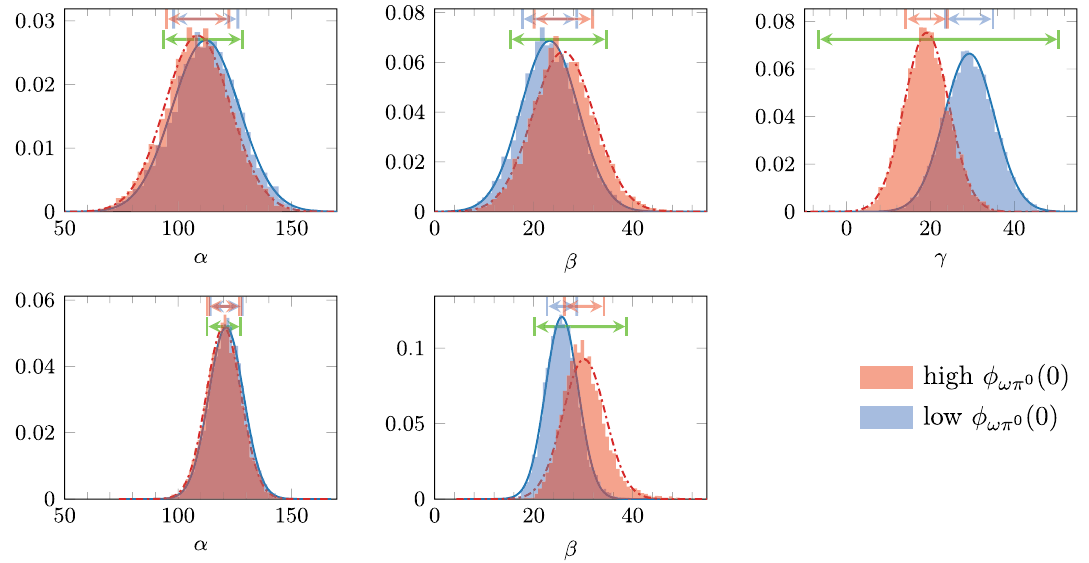
Fig. 13 One dimensional distributions of our computed Dalitz plot parameters in the Monte Carlo analysis performed, for the “3 par.” case (top row) and “2 par.” case (bottom row). A Gaussian distribution with the average and error quoted in Table 1 is superimposed for each